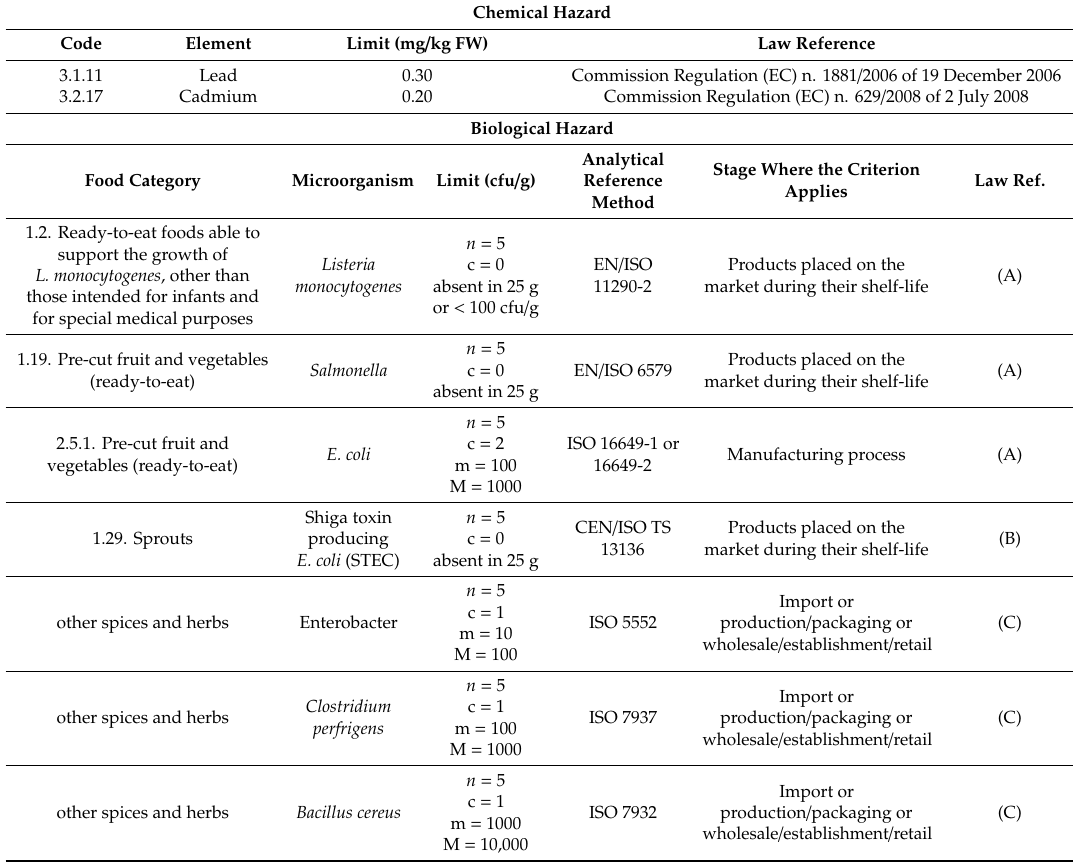
Table 6. Permissible limit of heavy metals and microbiological criteria for edible